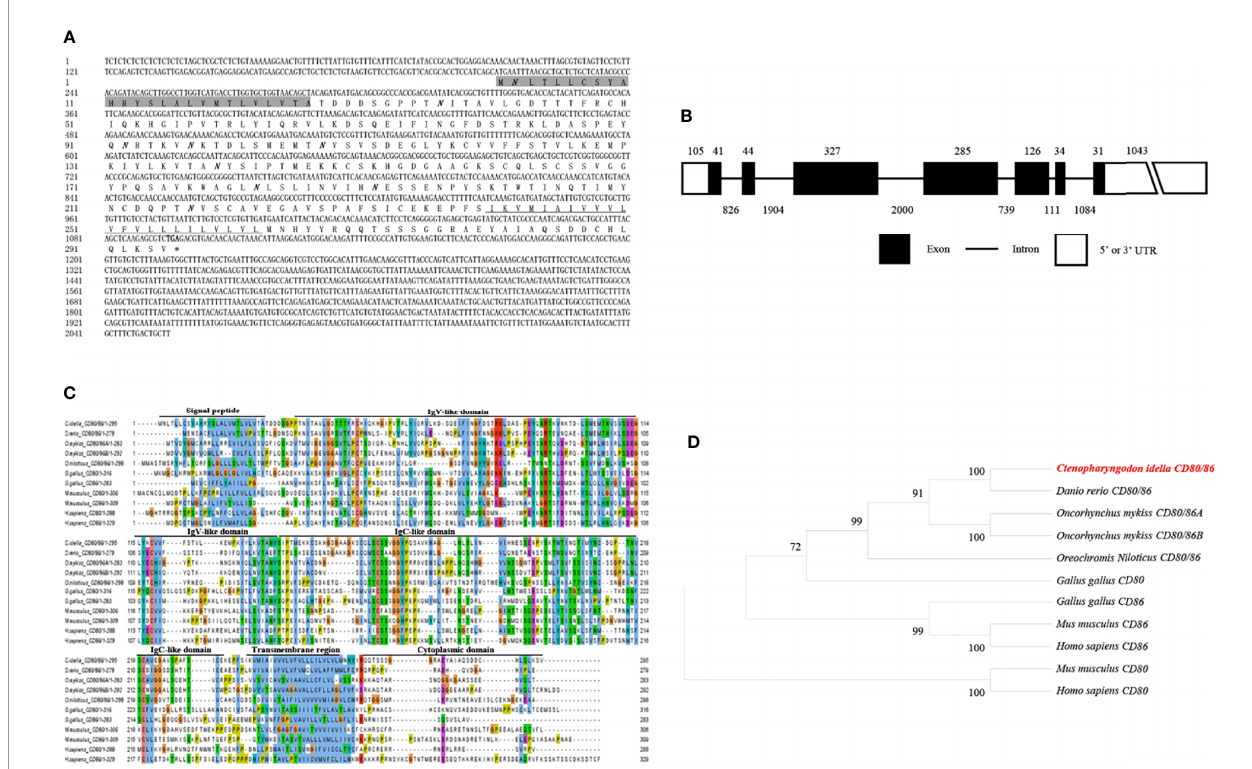
FIGURE 1 | Molecular cloning and bioinformatic analysis of the CD80/86 gene in grass carp. (A) The cDNA and deduced amino acid sequences for CD80/86. The signal peptide is shadowed, and the transmembrane domain is underlined. The stop codon is indicated by the asterisk. The locations of the predicted N-linked glycosylation sites (NGSs) are shown in bold and italic. (B) The exon/intron structure of the CD80/86 gene in grass carp. The rectangles represent the exons, and the lines between them indicate the introns. The black and white areas indicate the coding regions alongside the 5 ’ or 3 ’ untranslated regions (UTR), respectively. The size (bp) of the exons and introns are shown by the numbers above and below, respectively. (C) Multiple amino acid sequence alignment of CD80/86 homologs. The sequence alignment was conducted using the ClustalX program. The predicted domains of grass carp CD80/86 were marked above the amino acid sequence. (D) Phylogenetic analysis of CD80/86 homologs. Protein sequences were used to generate the phylogenetic tree using the neighbor-joining method bootstrapped 1000 times with the MEGA program. The grass carp CD80/86 is shown in red. The GenBank accession numbers for the used sequences are shown below: Homo sapiens CD80, NP_005182.1; H. sapiens CD86, NP_787058.5; Mus musculus CD80, NP_033985.3; M. musculus CD86, NP_062261.3; Gallus gallus CD80, CAJ18316.1; G. gallus CD86, CAJ18297.1; Danio rerio CD80/ 86, NP_001294992.1; Ctenopharyngodon idella CD80/86, OL692349; Oncorhynchus mykiss CD80/86A, XP_014070713.1; O. mykiss CD80/86B,